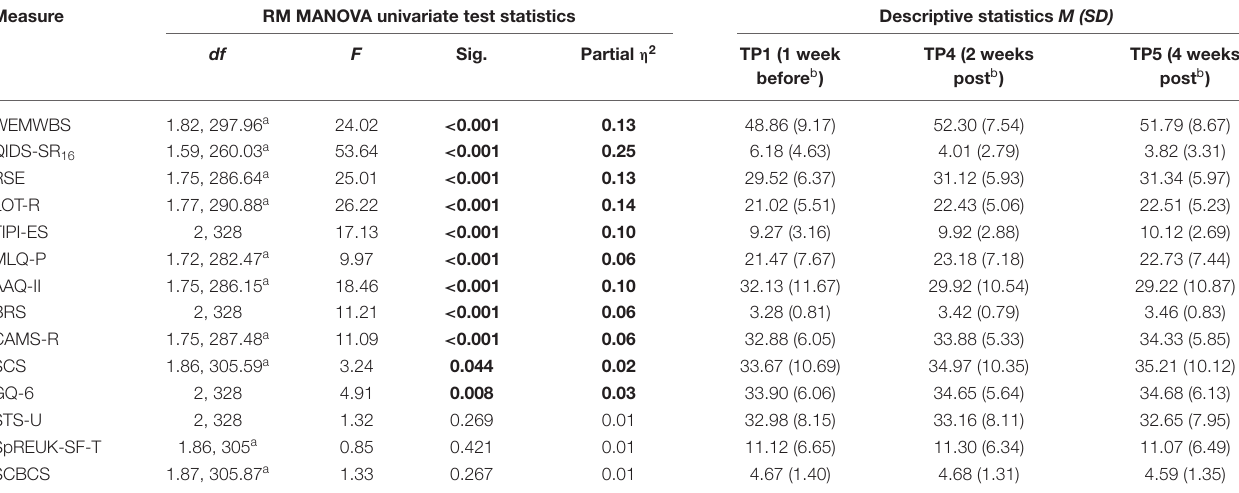
TABLE 4 | Output Repeated Measures Multivariate Analysis of Variance (RM MANOVA), testing for statistical significance of post-experience change in relevant outcomes.